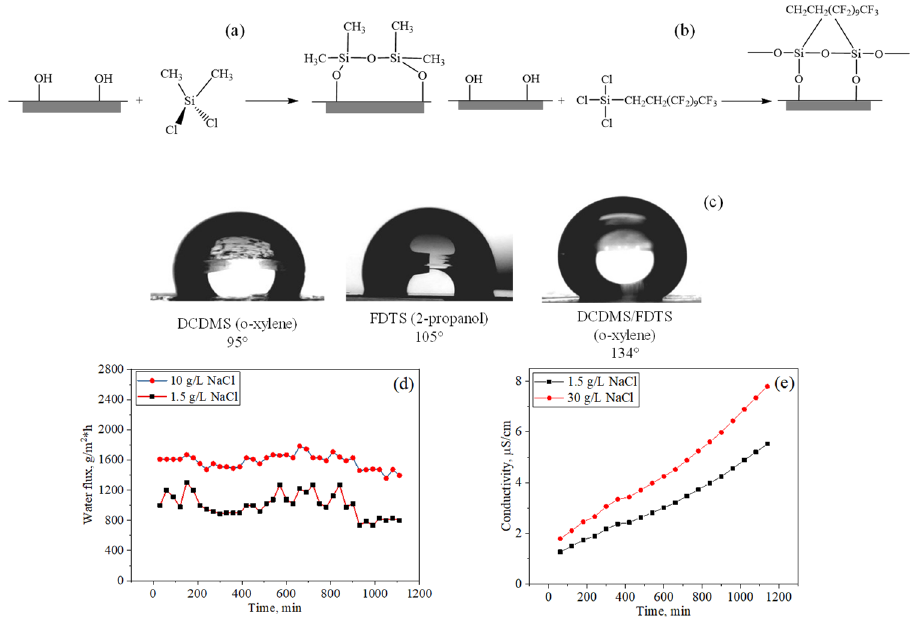
Figure 4. Scheme of modification of PET TeMs by covalent bonding of DCDMS ( a ) and FDTS ( b ); contact angle of modified PET TeMs ( c ); water flux ( d ) and conductivity ( e ) for NaCl solutions with concentrations of 1.5 and 10 g/L. Adapted from [178].